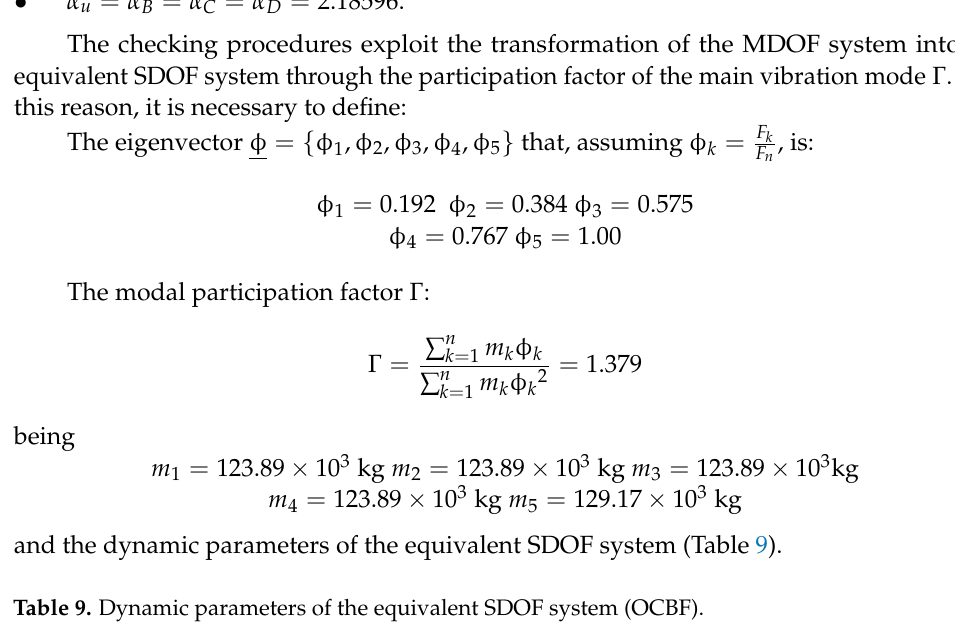
Table 9. Dynamic parameters of the equivalent SDOF system (OCBF).